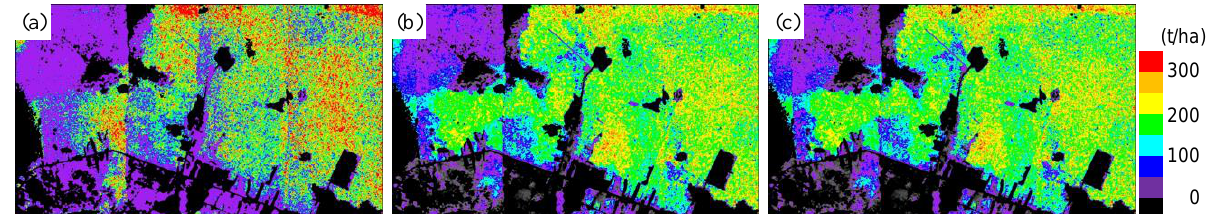
Figure 9. Estimated biomass maps by (a) PLS, (b) lasso, and (c) fused lasso